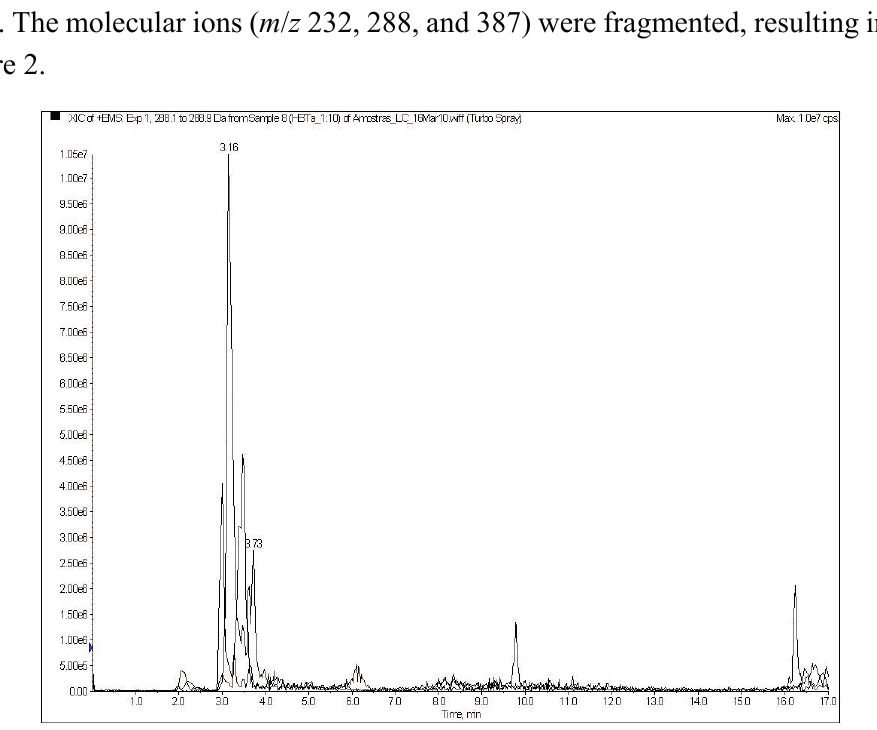
Figure 1. LC-ESI MS/MS chromatogram showing the major components in the M r 3000 permeate after a multi-enzyme hydrolysis of amaranth protein